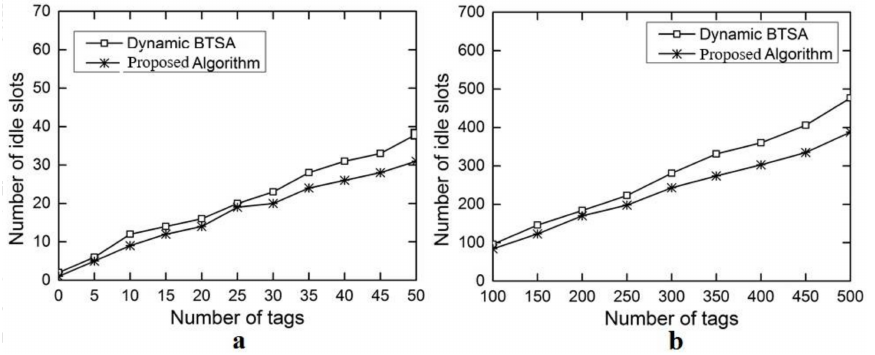
Figure 7. Comparison on the number of idle slots between DAF-OS and DBTSA. ( a ) Number of tags in the range 5–50; ( b ) number of tags in the range 100–500.